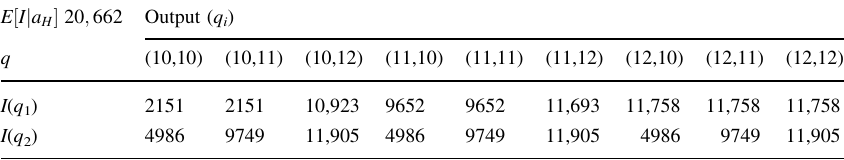
Table 5 Pay for performance using both divisions with transfer and unadjusted outcome